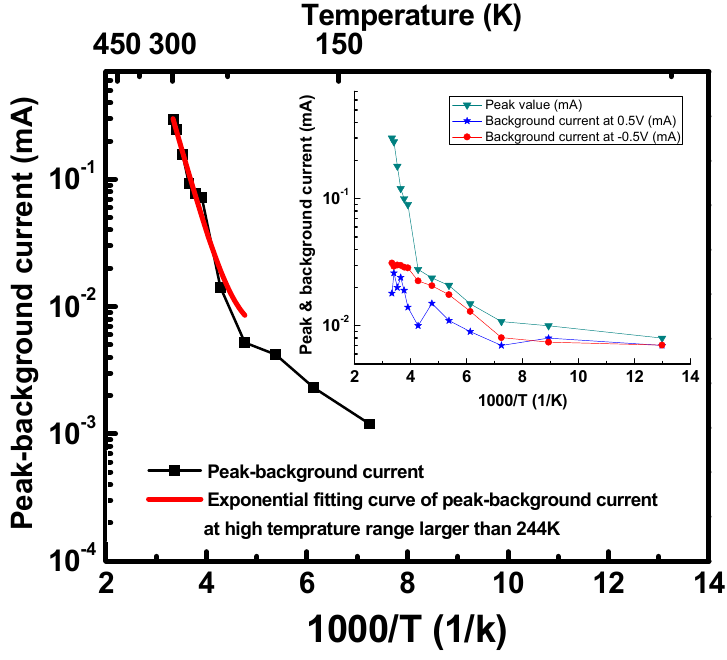
Figure 7. Arrhenius plot of the peak minus background current. The activation energy of rotation was extracted to be 0.3 eV by fitting curve of the measurement data higher than 244 K. The inset shows both the peak current and the background current at 0.5 V and − 0.5 V. The temperature independence of the background current implies tunneling transport of electrons